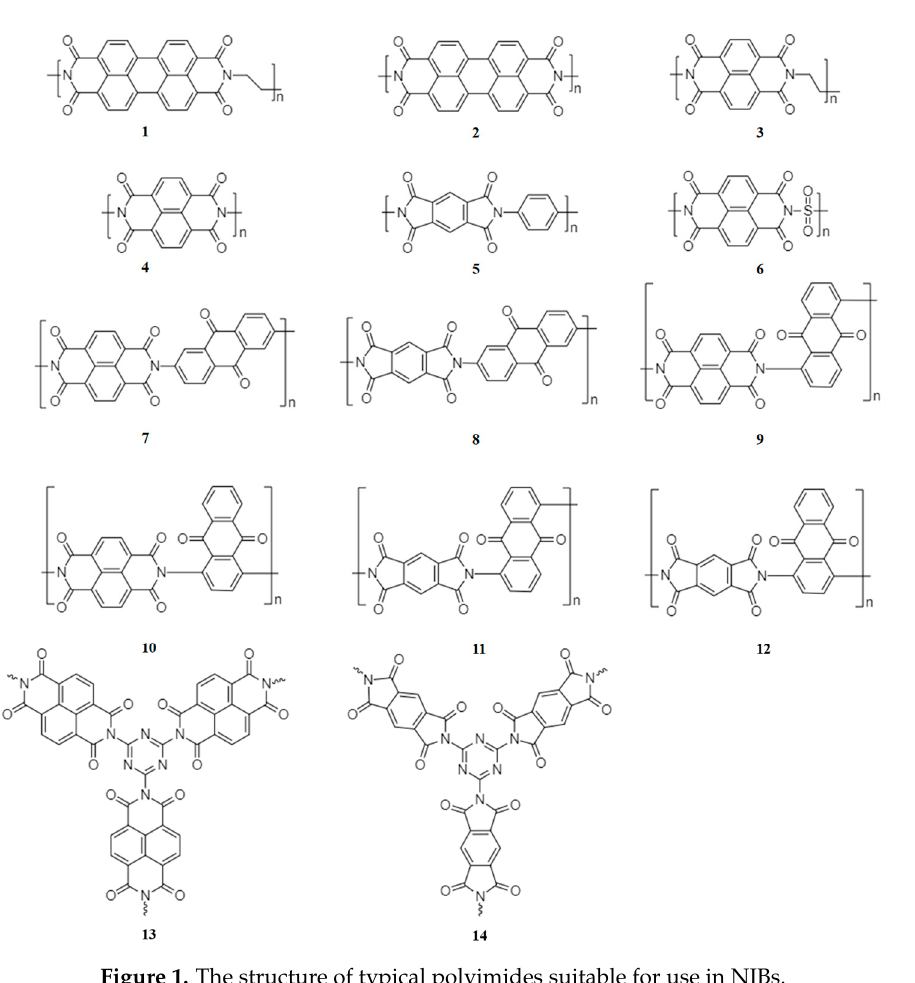
Figure 1. The structure of typical polyimides suitable for use in